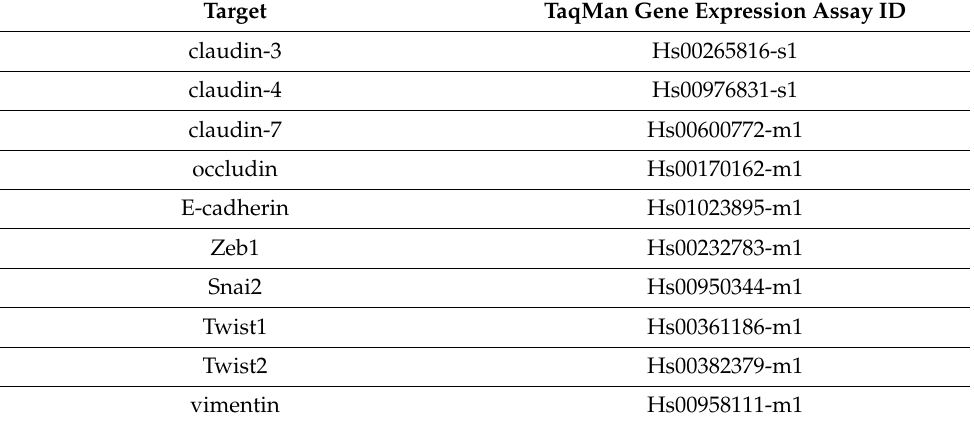
Table 1. TaqMan Gene Expression Assay for target genes obtained from Thermo Fisher as Assay-on- Demand